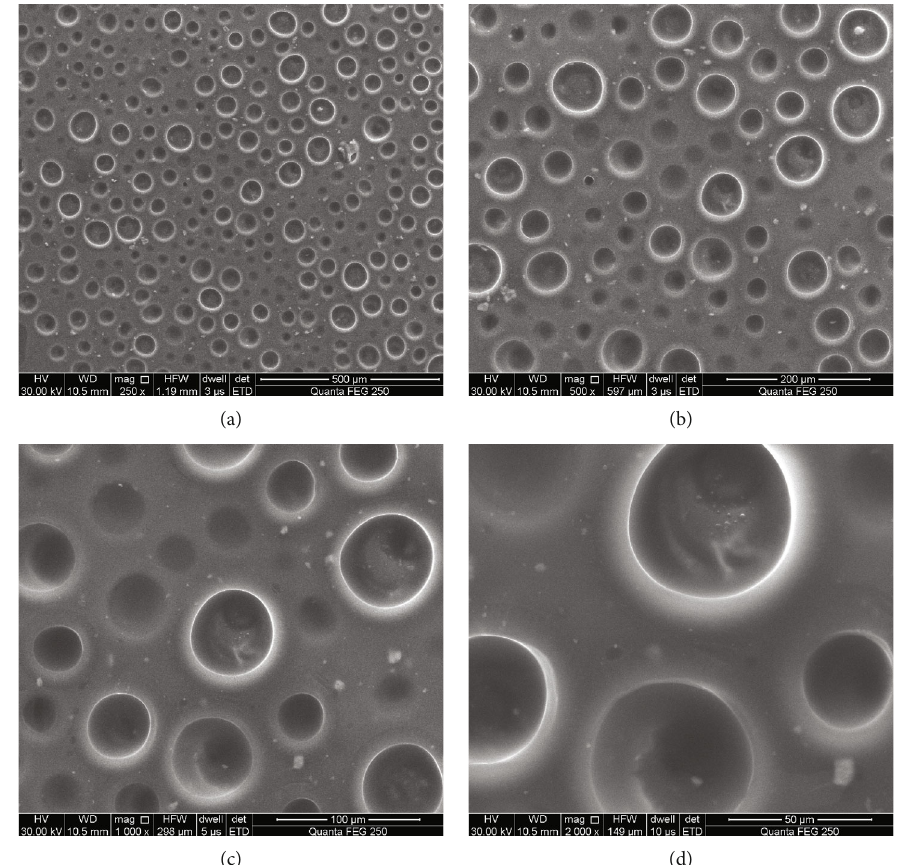
Figure 10: SEM images of CNT nanocomposite photothermal coating with di ff erent magni fi cations. (a) 2000. (b) 1000. (c) 500. (d)